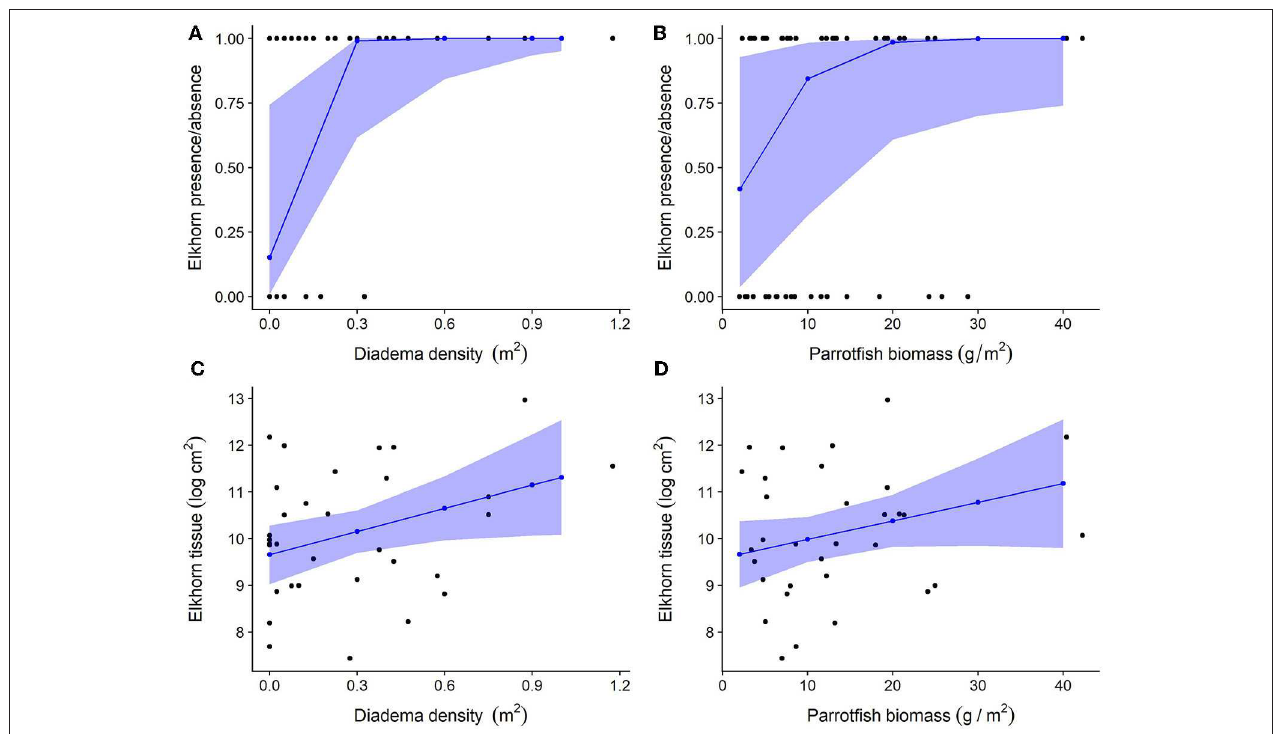
FIGURE 6 | Relationship between herbivore groups and elkhorn coral. For all plots, black dots represent raw data points, blue dots, and lines represent unscaled model estimates and 95% confidence intervals from the final model. (A,B) Relationship between elkhorn coral presence and Diadema density and parrotfish biomass; (C,D) Relationship between elkhorn LAI and Diadema density and parrotfish